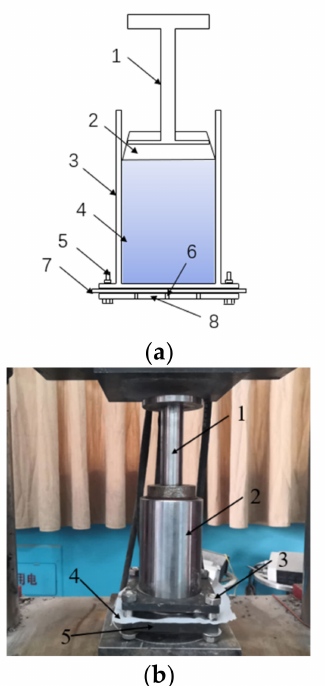
Figure 4. Principle and model of double-high curing device: ( a ) principle of double-high curing device; ( b ) model of double-high curing device; ( a ) 1—pressure lever; 2—rubber stropper; 3—slurry tank; 4—curing pressure slurry; 5—bolt; 6—drain hole; 7—filter cloth; 8—base; ( b ) 1—Pressure lever; 2—slurry tank; 3—bolt; 4—filter cloth;